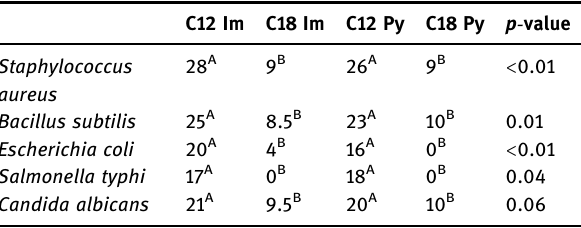
Table 1: Diameter of the inhibition zone in mm ( median ) against each